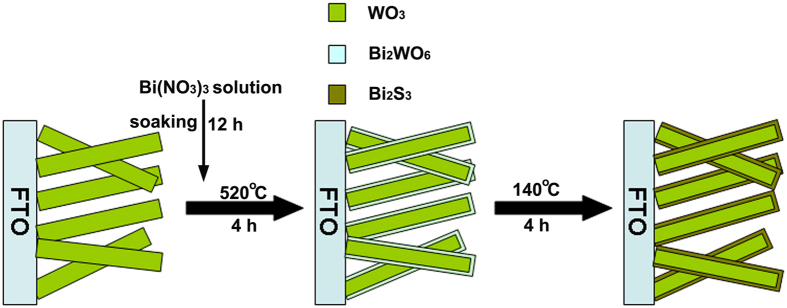
Depiction of the synthesis process of Bi2S3/WO3 films.